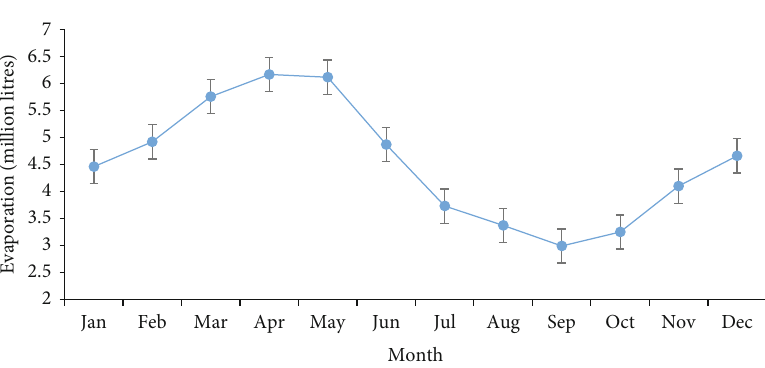
Figure 7: Monthly water from evaporation due to FPV. Table 6: FPV power generation capacity of GERD at di ff erent area of coverage.